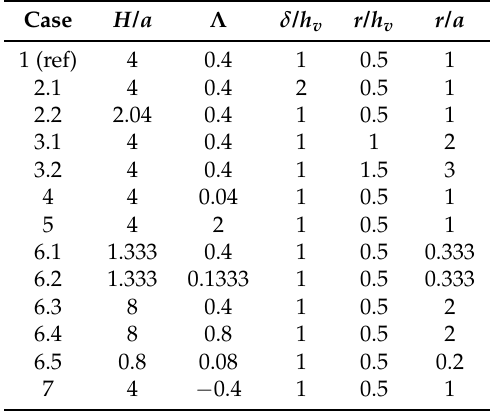
Table 1. Summary of the high resolution nonlinear simulations performed. Case H /